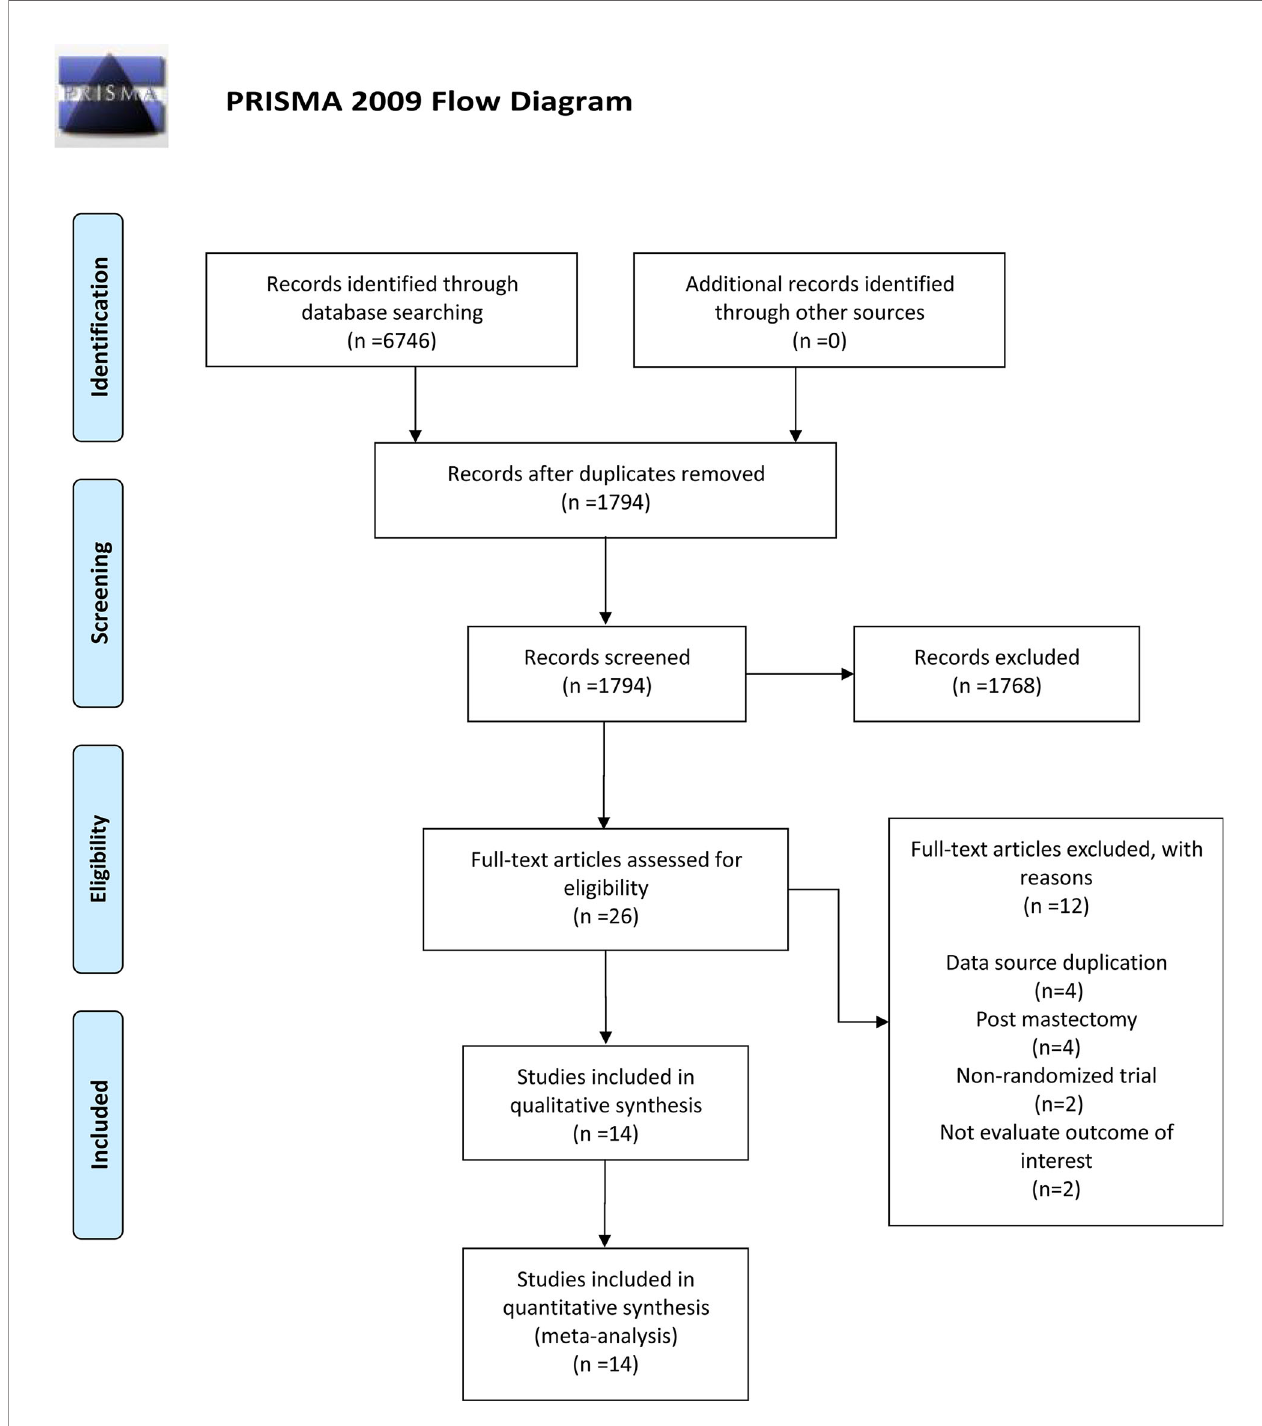
FIGURE 1 | Flowchart of article selection for